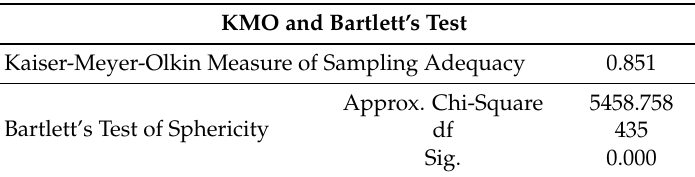
Table 7. Showing exploratory factor analysis